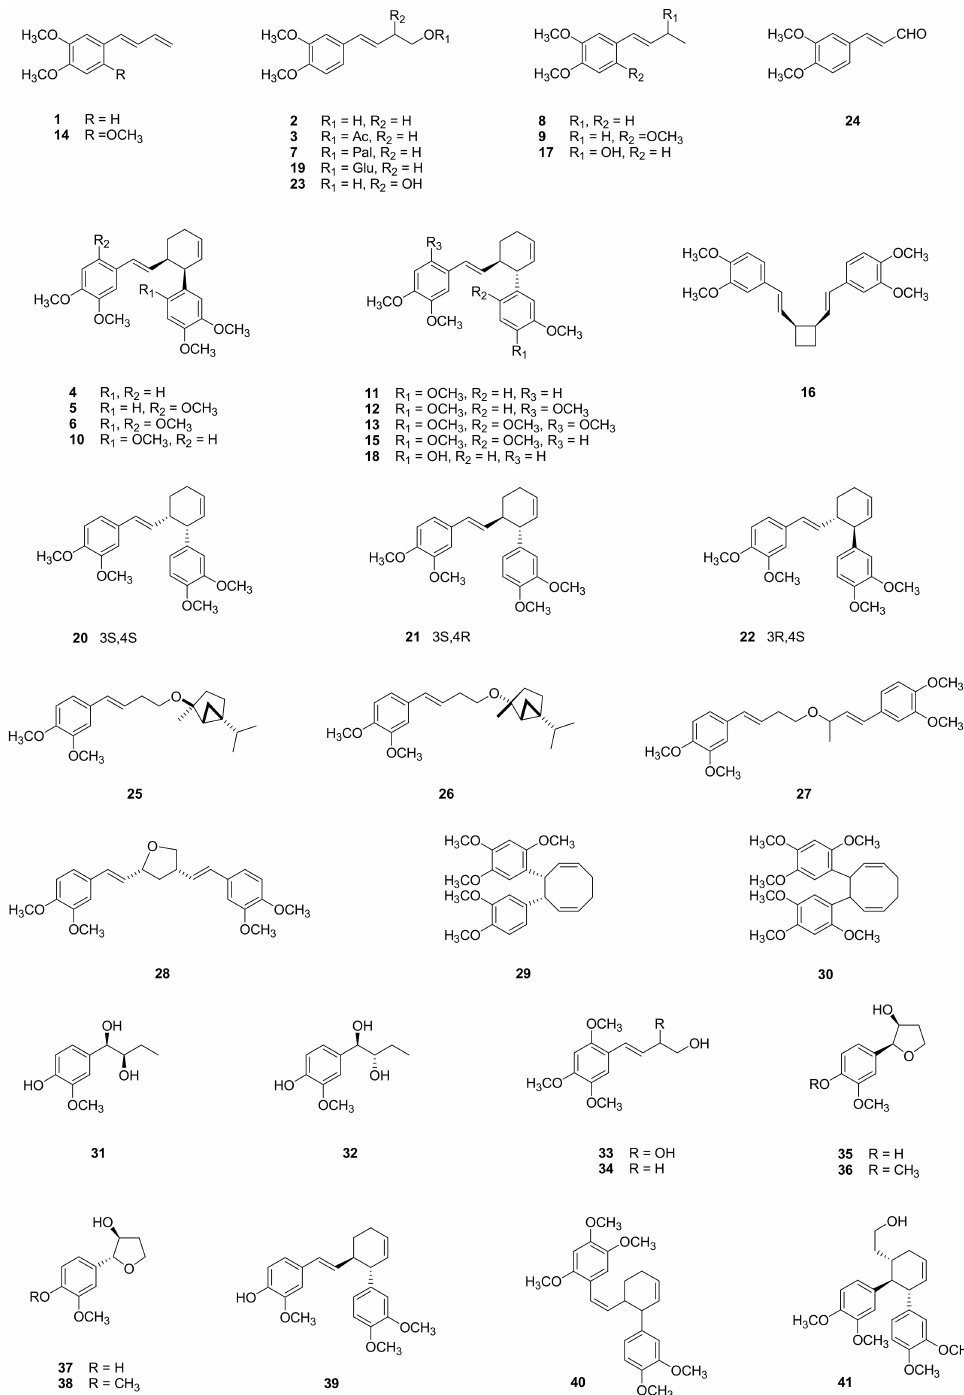
Figure 2. Structures of phenylbutenoids isolated from Z. cassumunar